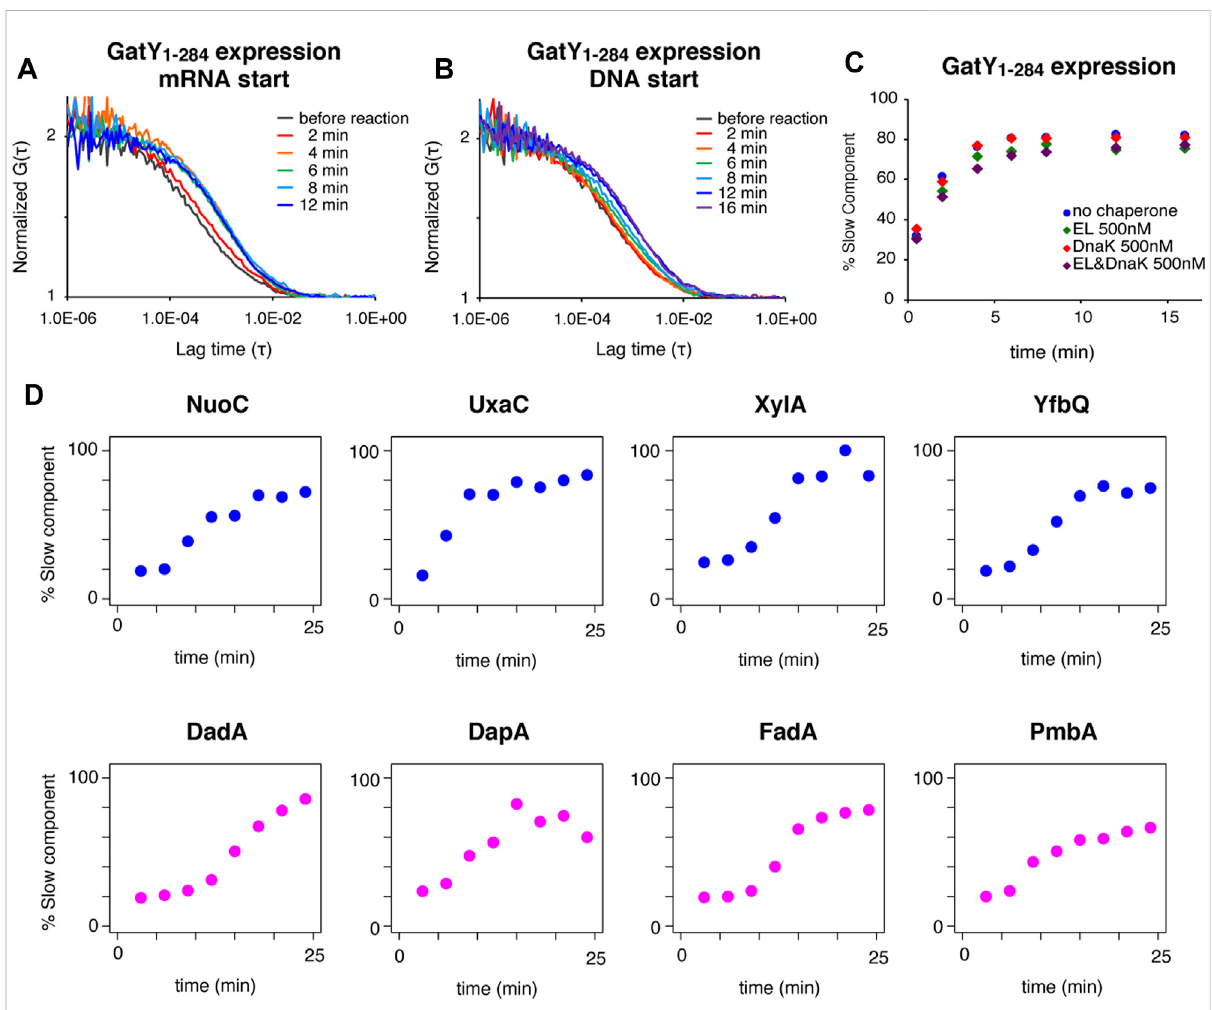
FIGURE 2 Real-time observation of interactions between TF and ribosome-nascent chain complex by FCS. (A) Autocorrelation curves at each reaction time of Alexa488-labeledTF during protein synthesis of gatY 1-284 by thePURE system initiated by mRNA addition. (B) Autocorrelation curves at each reaction time of Alexa488-labeled TF during protein synthesis of gatY 1-284 by the PURE system initiated by DNA addition. (C) Time-dependent changes in the populations of the slow diffusion component during protein synthesis of gatY 1-284 by the PURE system. The population was obtained by curve fi tting with a two-component model. The concentration of the Alexa488-labeled TF was 100 nM. When the excess amount of DnaK (500 nM) was added, DnaJ and GrpE were also added at 200 nM. (D) Time-dependent changes in the populations of the slow diffusion componentduringproteinsynthesisofeachgeneunderthe0.2×EF-Gconcentrationcondition. Thepopulationwasobtained bycurve fi ttingwitha two-componentmodel. The upper(NuoC, UxaC,XylA, and YfbQ) andthelower (DadA,DapA, FadA,and PmbA)proteins haverelatively hydrophobic and hydrophilic properties at the N-termini, respectively (see Supplementary Figure S2C for the hydropathy